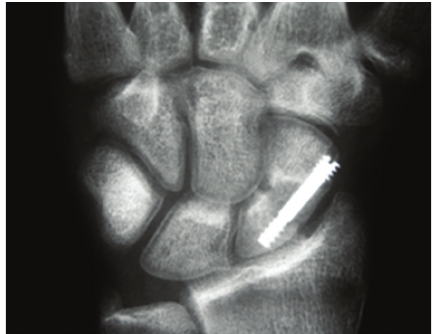
Figure 1: AP-radiograph of a 16-year-old patient in the follow up after screw fixation of a scaphoid fracture showing bandlike sub- chondral osteoporosis in all carpal bones.